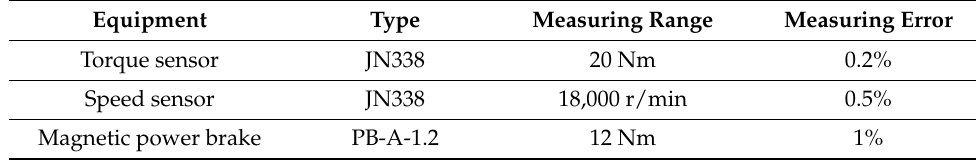
Table 2. Main measuring